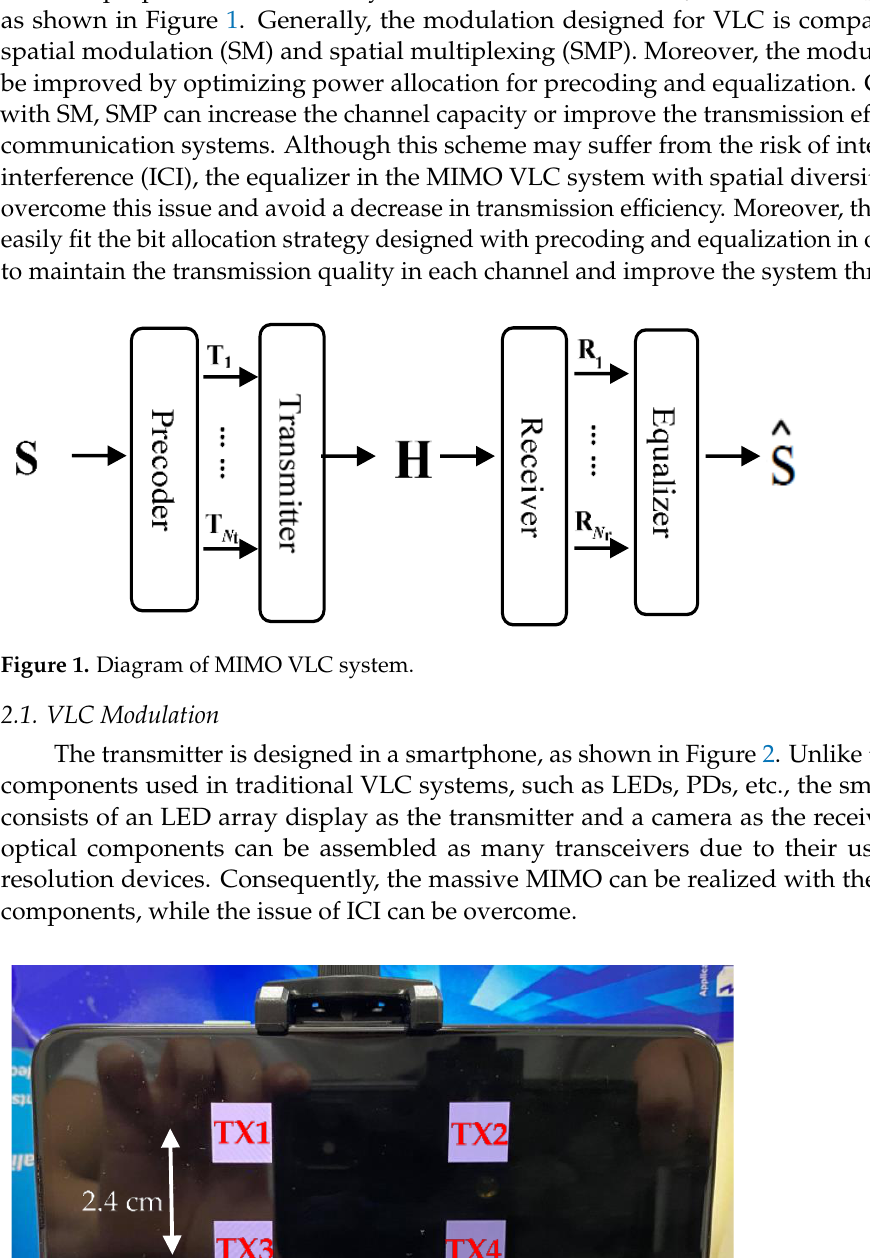
Figure 2. The paradigm of four transmitters in a 4 × 4 MIMO VLC system.